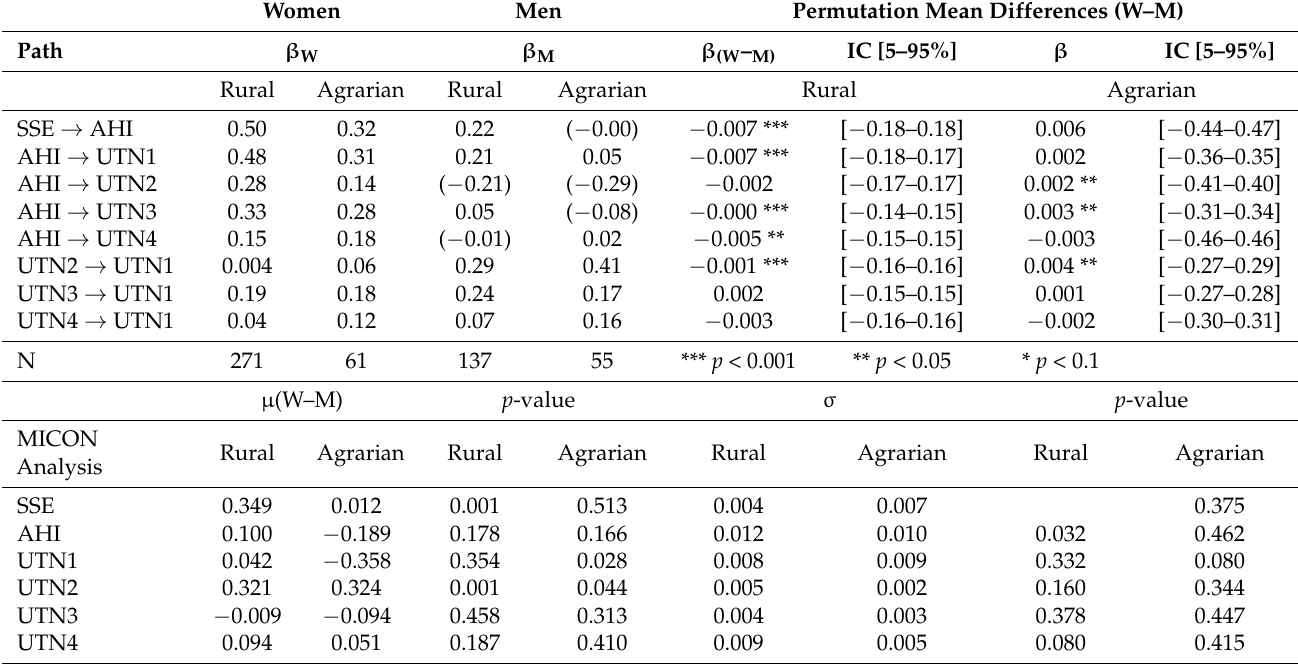
Table 7. Moderation